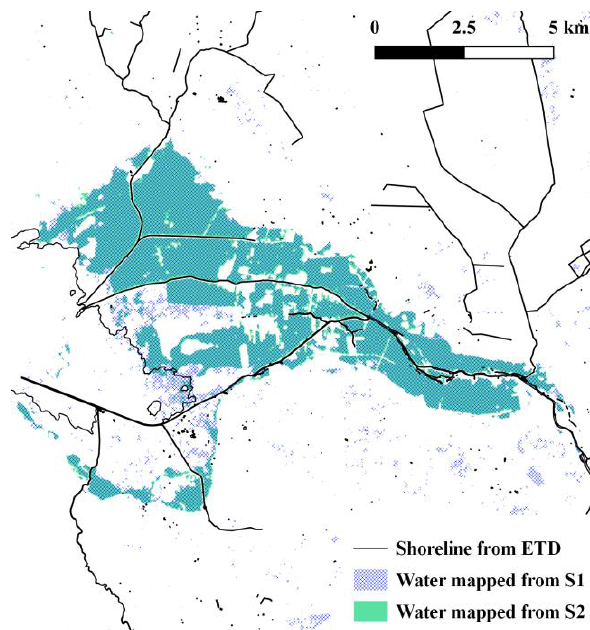
Figure 5. Water mapped on 05.04.2019 from Sentinel-1 IW image (VH polarization) and Sentinel-2 image